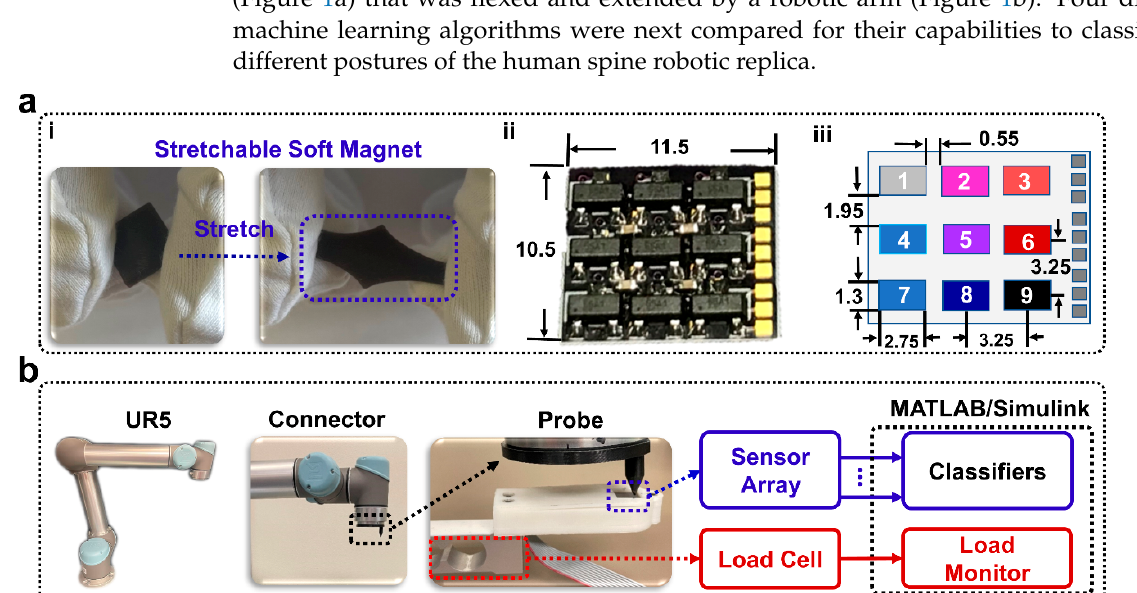
Figure 2. Robotically probing soft magnet to classify location and amplitude of external loads. ( ai ) The stretchable soft magnet. ( aii ) The Hall effect sensor array PCB with dimensional units of mm. ( aiii ) Each individual Hall effect sensor taxel position was numbered and physical dimensions were labeled with units of mm. ( b ) The UR5 applied loads to the soft magnet that was placed atop the 3 × 3 Hall effect sensor array within the 3D-printed housing. These nine Hall effect sensor signals were recorded in Simulink and classified with four machine learning algorithms in MATLAB.